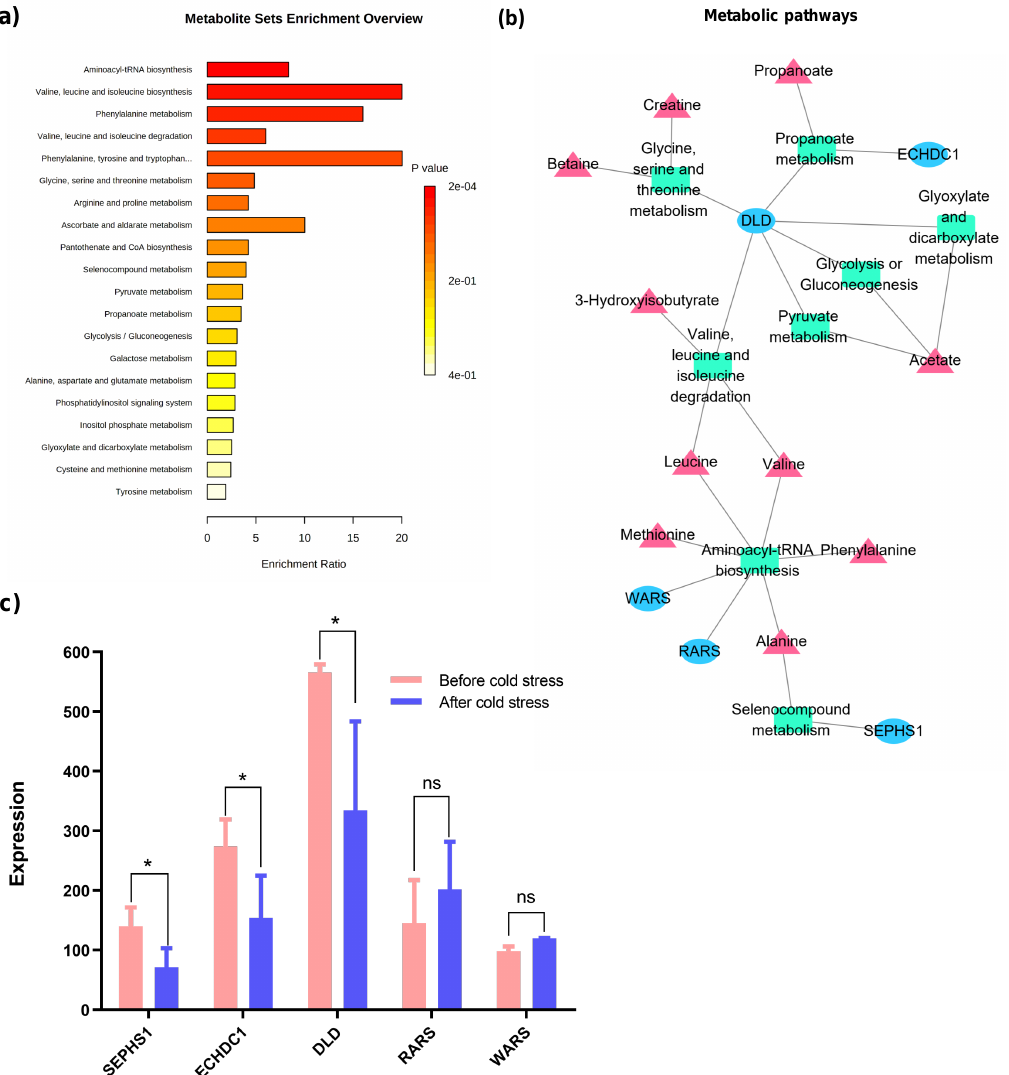
Figure 7. Networks between metabolites and genes involved in metabolic pathways. ( a ) Overview for metabolite set enrichment analysis of metabolic response to cold stress in Sanhe cattle. ( b ) Relevant metabolic pathways involved in the response to cold stress in Sanhe cattle. Triangles represent metabolites, ovals represent genes, and rectangles are the metabolic pathways. ( c ) The changes of gene expressions involved in metabolic pathways. *: p -Value < 0.05; ns: no significance; SEPHS1 : selenophosphate synthetase 1; ECHDC1 : enoyl coenzyme A hydratase domain containing 1; DLD : dihydrolipoamide dehydrogenase; RARS : arginyl-tRNA synthetase; WARS : tryptophanyl-tRNA